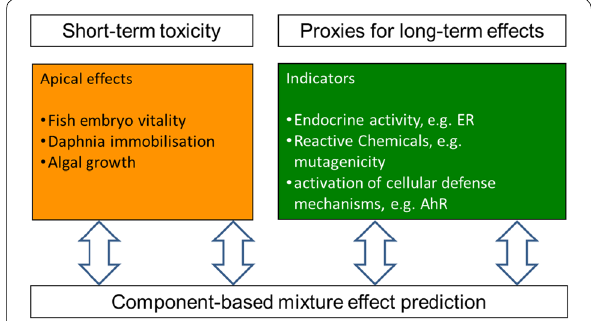
Fig. 1 Recommended test battery of in vivo (orange) and in vitro (green) bioassays. ER estrogen receptor, AhR aryl hydrocarbon